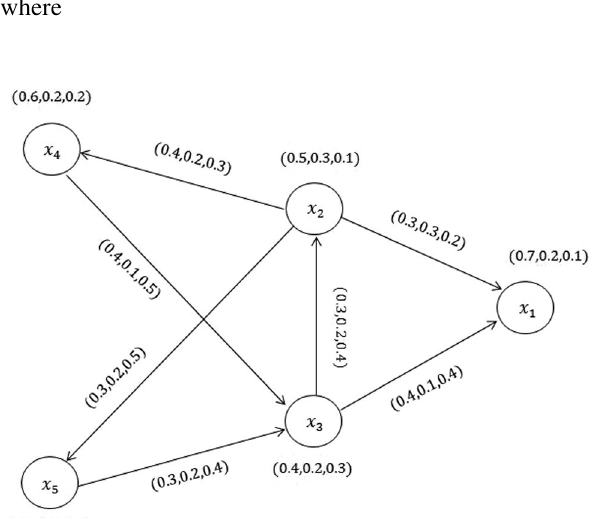
Fig. 5 A PFDG G = ( A , 𝐁